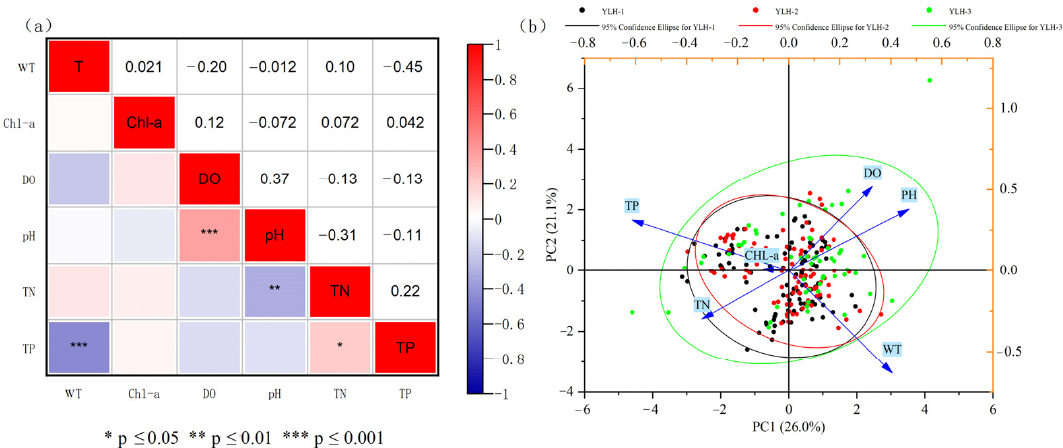
Figure 8. Correlations of each water parameter ( a ) and principal component ( b ) analysis of Lake Yilong.